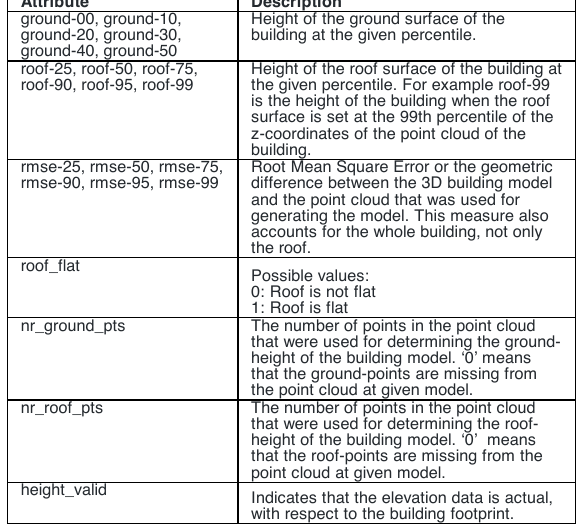
Table 1: Selection of height and quality attributes assigned